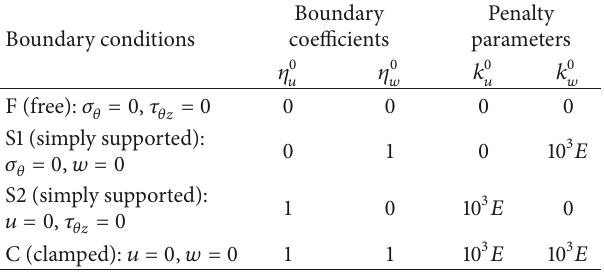
Table 1: Values of 𝜂 𝑙 𝑢 , 𝜂 𝑙 𝑤 , 𝑘 𝑙 𝑢 , and 𝑘 𝑙 𝑤 for different classical boundary